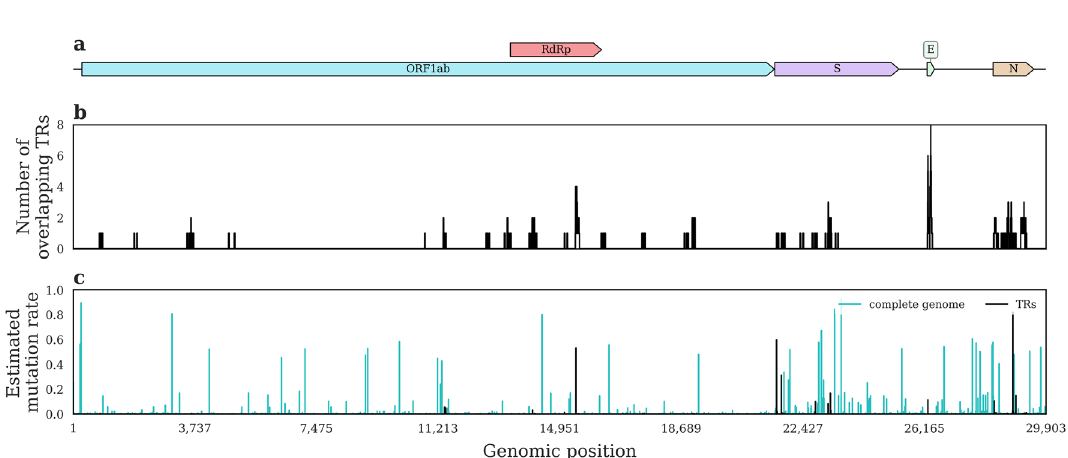
Figure 1. Overview of PCR primer TRs and average rate of mutations along the length of the SARS-CoV-2 genome. ( a ) SARS-CoV-2 isolate Wuhan-Hu-1, complete genome (NCBI ID of the fasta sequence: NC_045512) showing genes coding proteins located in ORF1ab (including RdRp), spike protein (S), envelope protein (E), and nucleocapsid protein (N). ( b ) Number of TRs overlapping a genomic position across all investigated primer sets. ( c ) Estimated mutation rate of a genomic position in the CoVEO database. For details, see “Methods”. For the estimated mutation rate of different genomic positions in samples belonging to various variant strains, see Supplementary Fig.